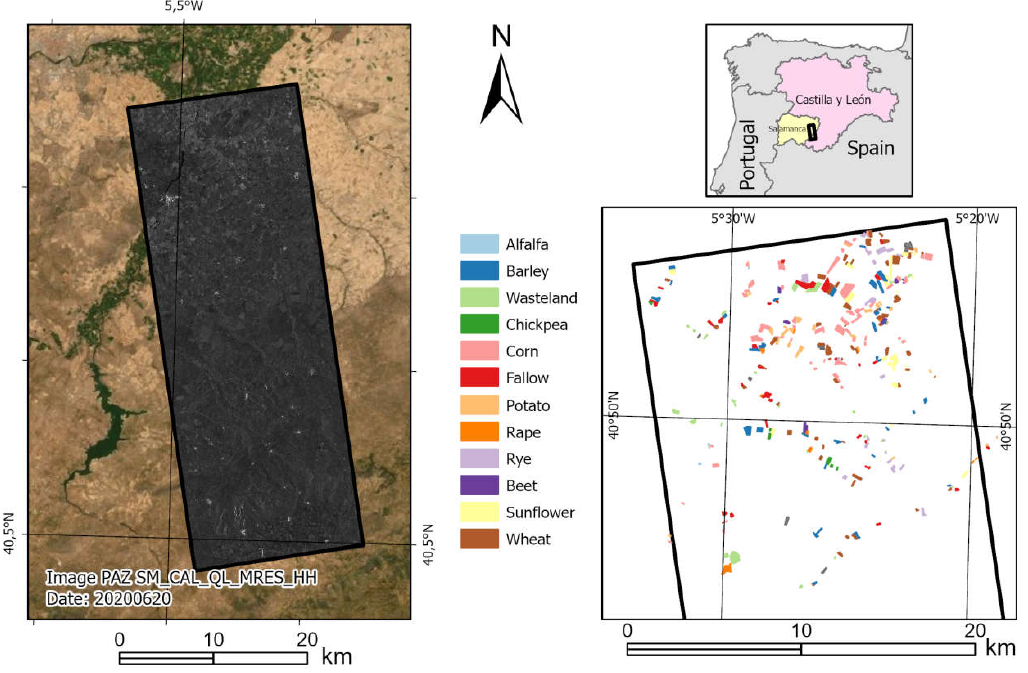
Figure 1. Location map of the study area and ground-truth dataset. Table 1. Ground-truth dataset for classification